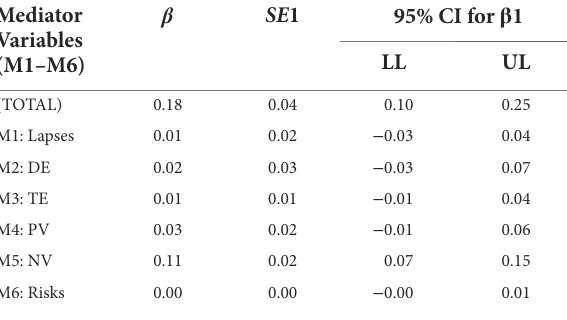
TABLE 3 Completely standardized indirect effects of Conscientiousness on COVID 19 Guideline Adherence. Mediator Variables